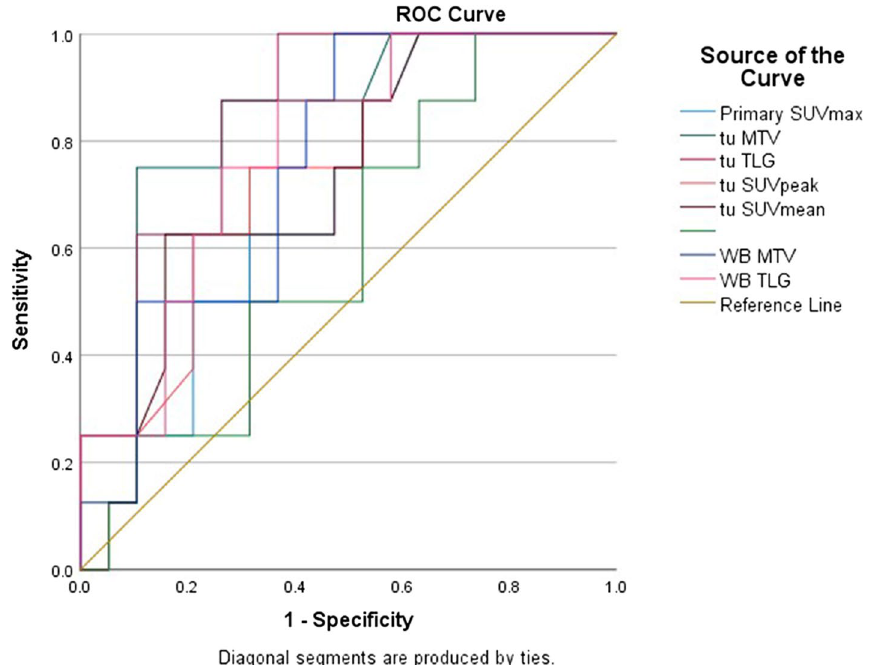
Fig. 3 ROC curve of the predictors of overall